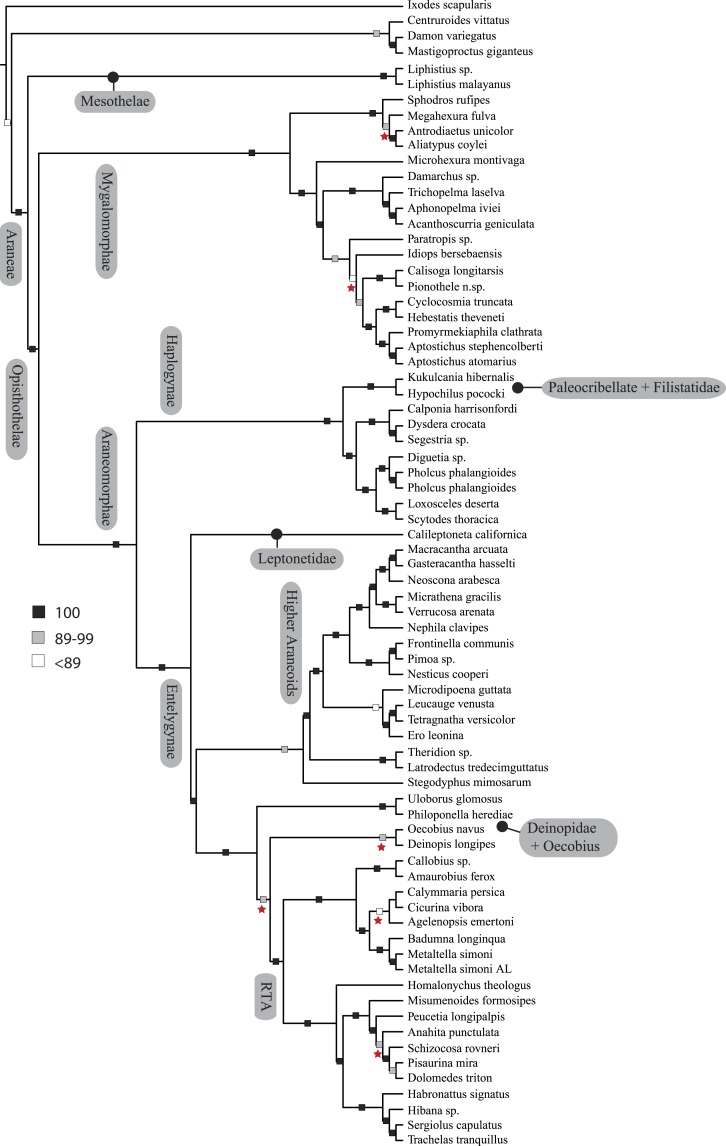
ASTRAL gene tree analysis of spider relationships based on 3,398 genes.Relative support value ranges reported at each node (inset legend); red stars indicate branches not congruent with tree shown in Figs. 1 and 2.